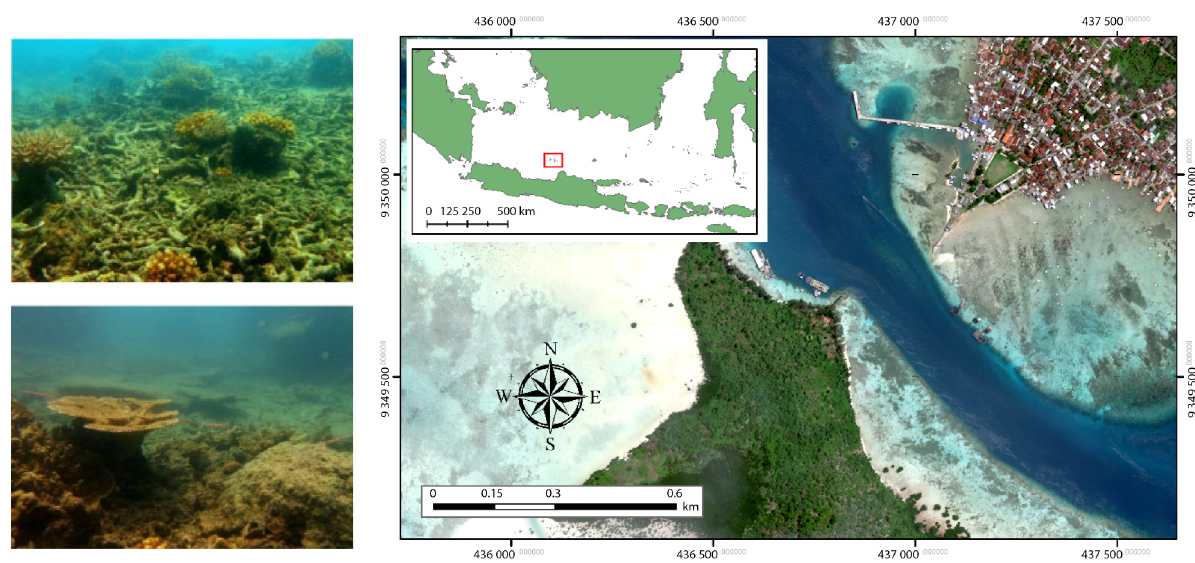
Figure 1. Study area for bathymetry retrieval in Karimun water with extensive area of coral reef (left, source: